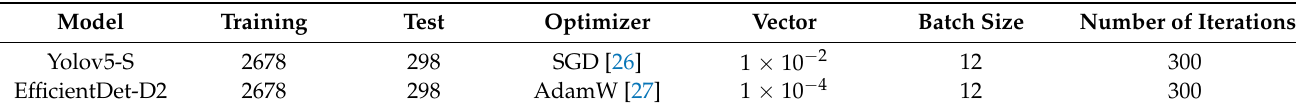
Table 6. Details of model